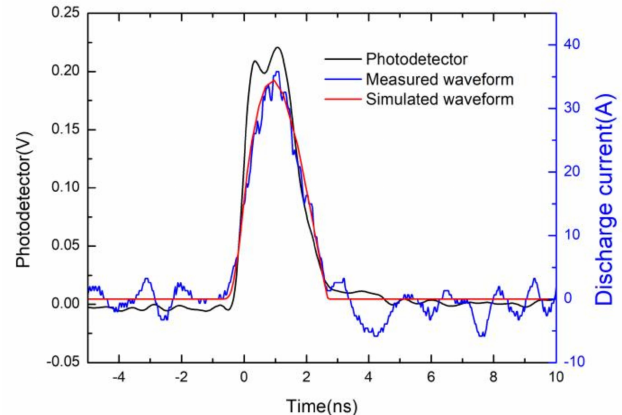
Figure 11. Laser pulse waveform, discharge current waveform obtained by differentiation (measured waveform), and simulated discharge current